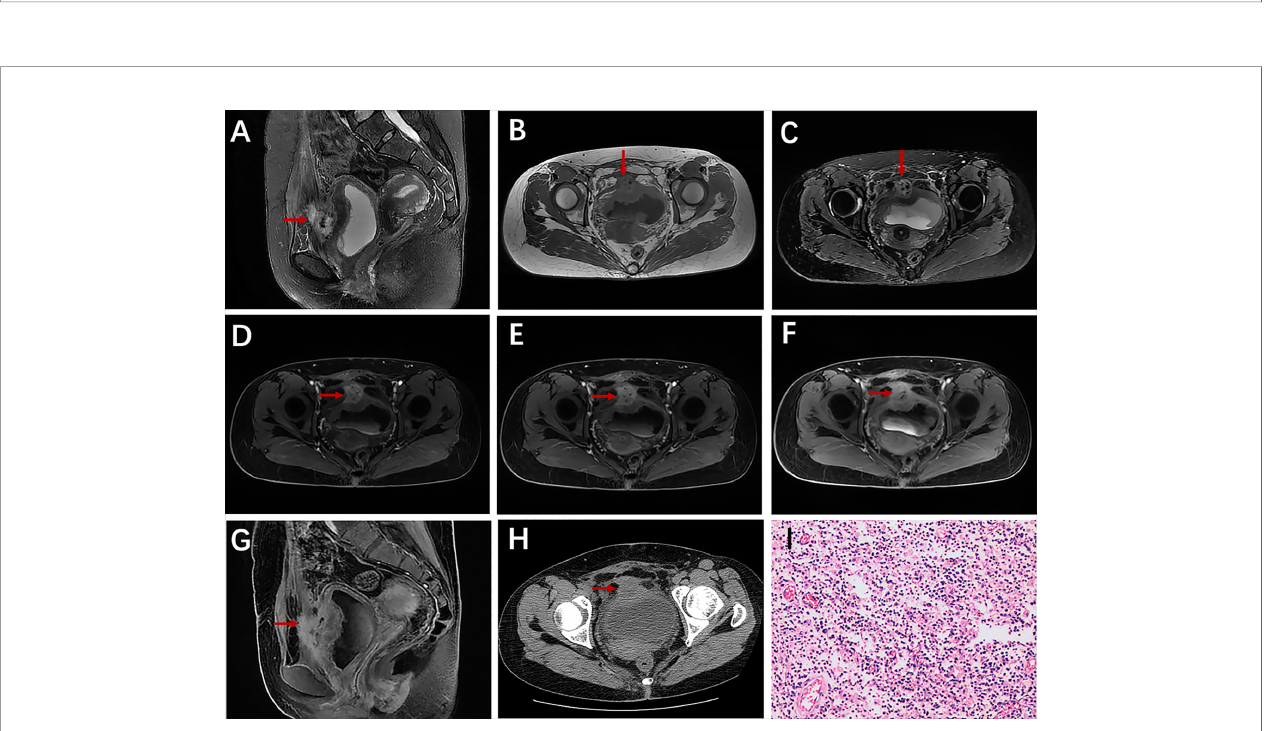
FIGURE 4 | A 38-year-old woman with urachal infection presented with pollakiuria and dysuria. Sagittal T2WI (A) showed a mainly solid mass in the urachal region; iso-intensity on T1WI (B) and T2WI (C) , and the adjacent bladder wall thickened obviously; axial dynamic contrast-enhanced LAVA-Flex images and sagittal contrast- enhanced images (G) showed obvious enhancement (D – F) ; no calci fi cation on axial CT plain scan (H) ; pathological fi ndings con fi rmed urachal infection (I)